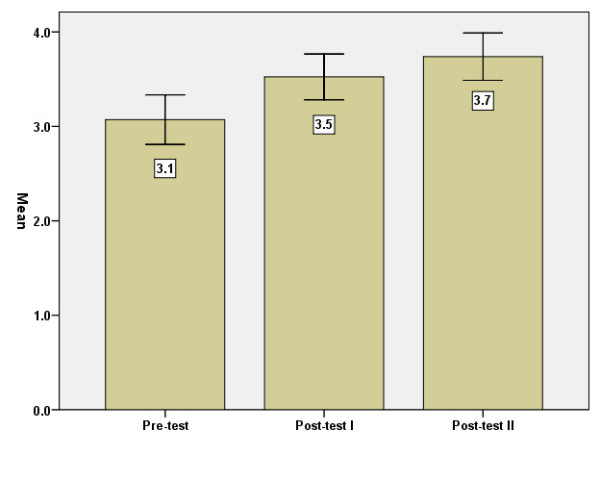
General health, means, before = baseline (I), immediately after (II) and three months after (III) the intervention. Error Bars: +/- 1.96 SE.